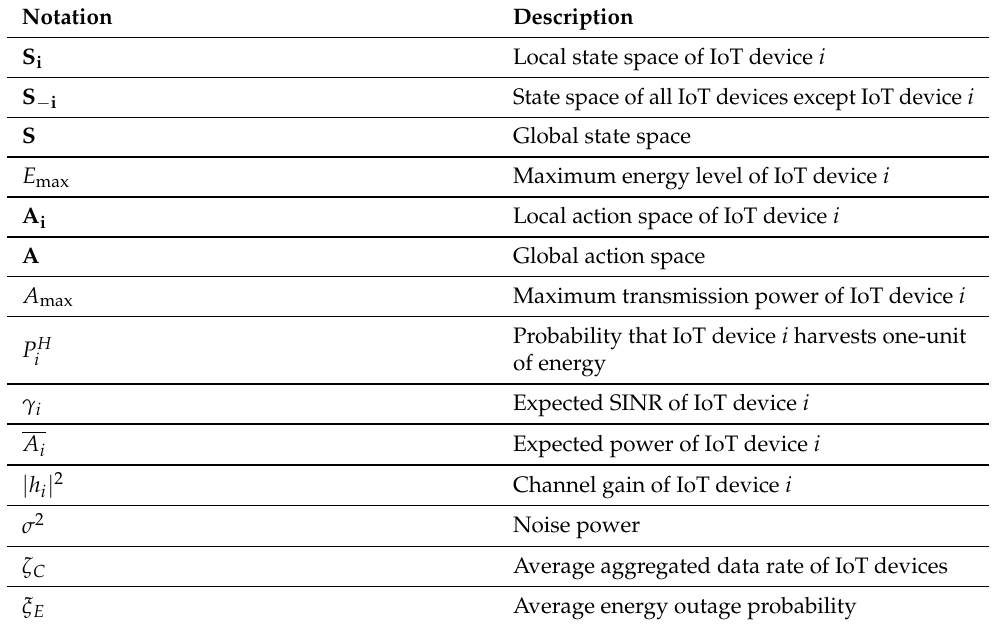
Table 1. Summary of